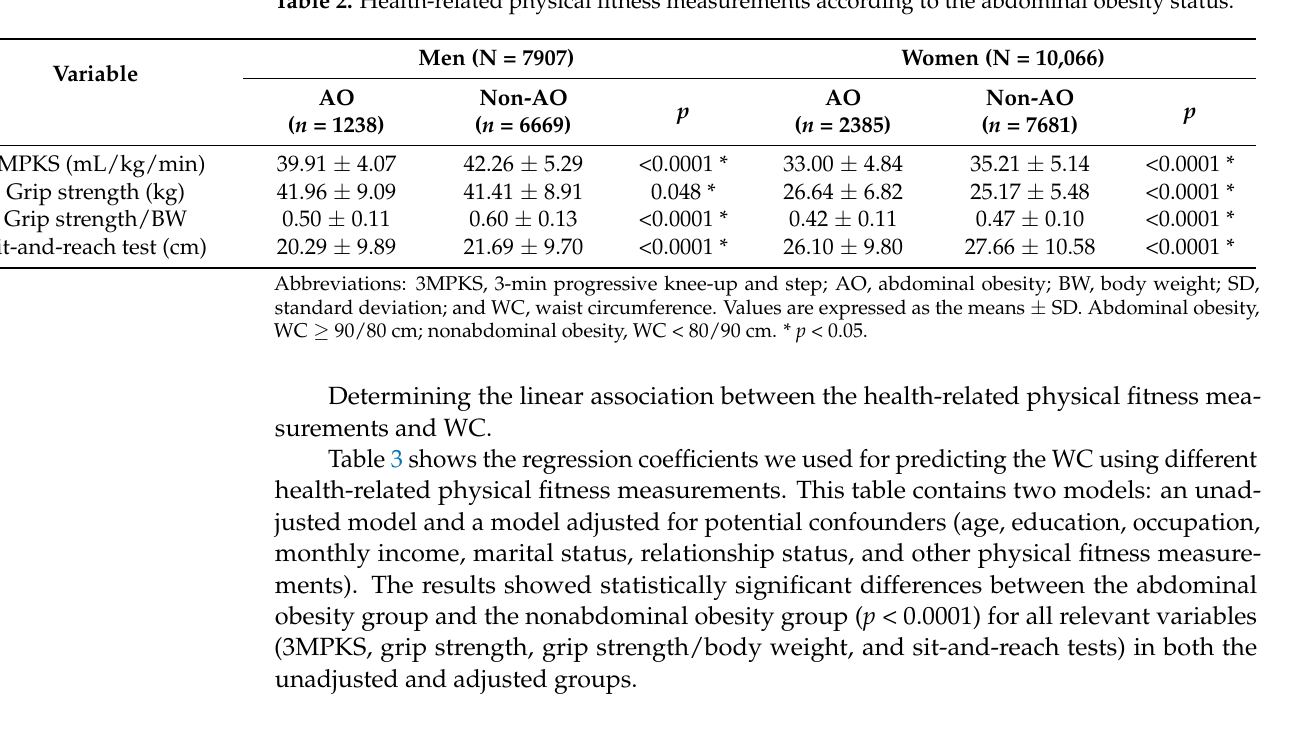
Table 3. Regression coefficients for predicting waist circumference using different health-related physical fitness